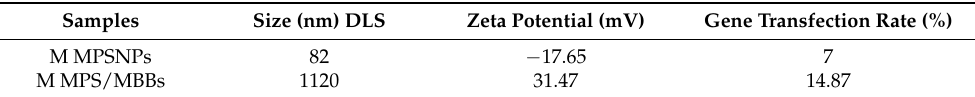
Table 5. The important characteristics of M MPSNPs and M MPS/MBBs for DNA delivery.